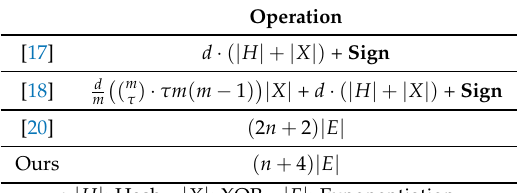
Table 3. Comparison of computational costs necessary for signature generation.